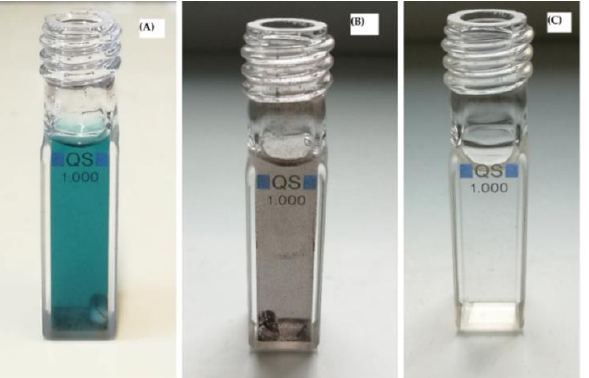
Figure 11. Visual representation of MB degradation in photo-Fenton process in the photo-reactor (cuvette). ( A ) Mixture of MB + NP-3 before photocatalysis, ( B ) MB + NP-3 after photocatalysis, and ( C ) clear solution obtained after separation (centrifugation) of solid catalyst from ( B ).